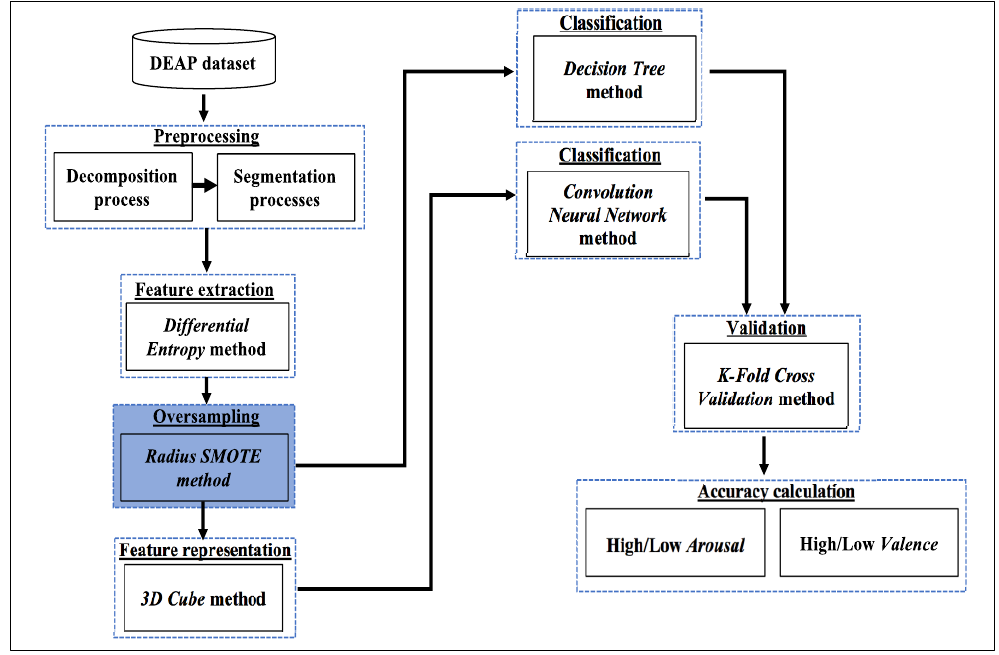
Figure 1. EEG signal-based emotion recognition flowchart